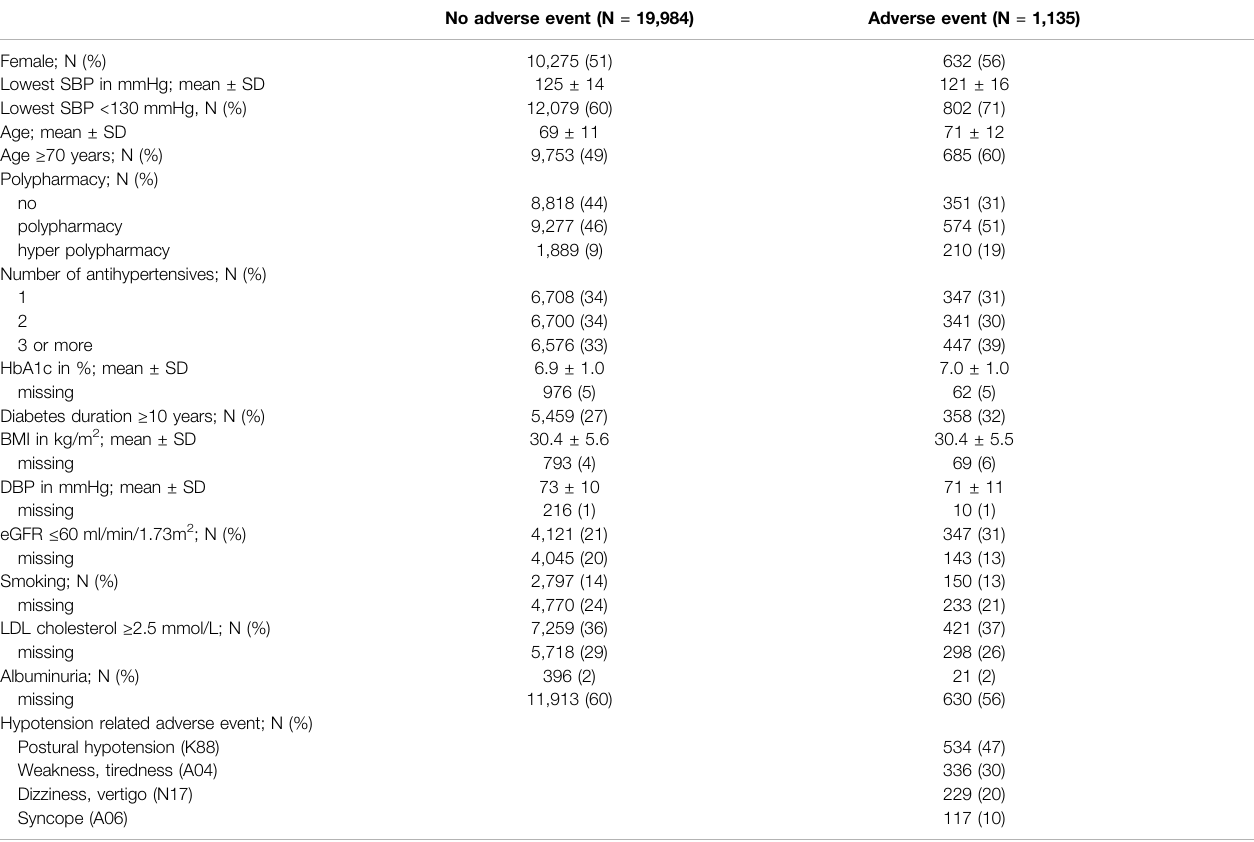
TABLE 1 | Patient